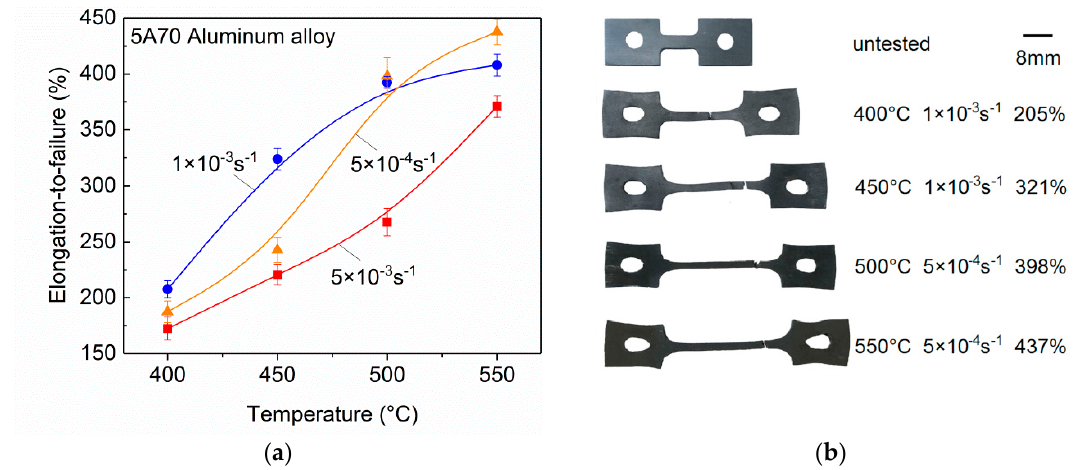
Figure 3. Superplastic elongation-to-failure results ( a ) and the specimens with excellent δ values at different temperatures, 400–550 °C, and different initial strain rates, 5 × 10 − 4 –5 × 10 − 3 s − 1 ( b ).